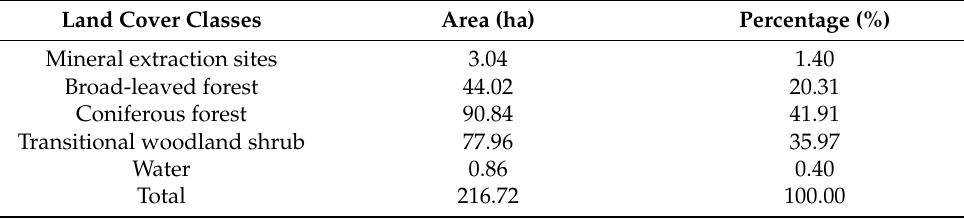
Table 2. Land cover classes, total values are a result of the PlanetScope